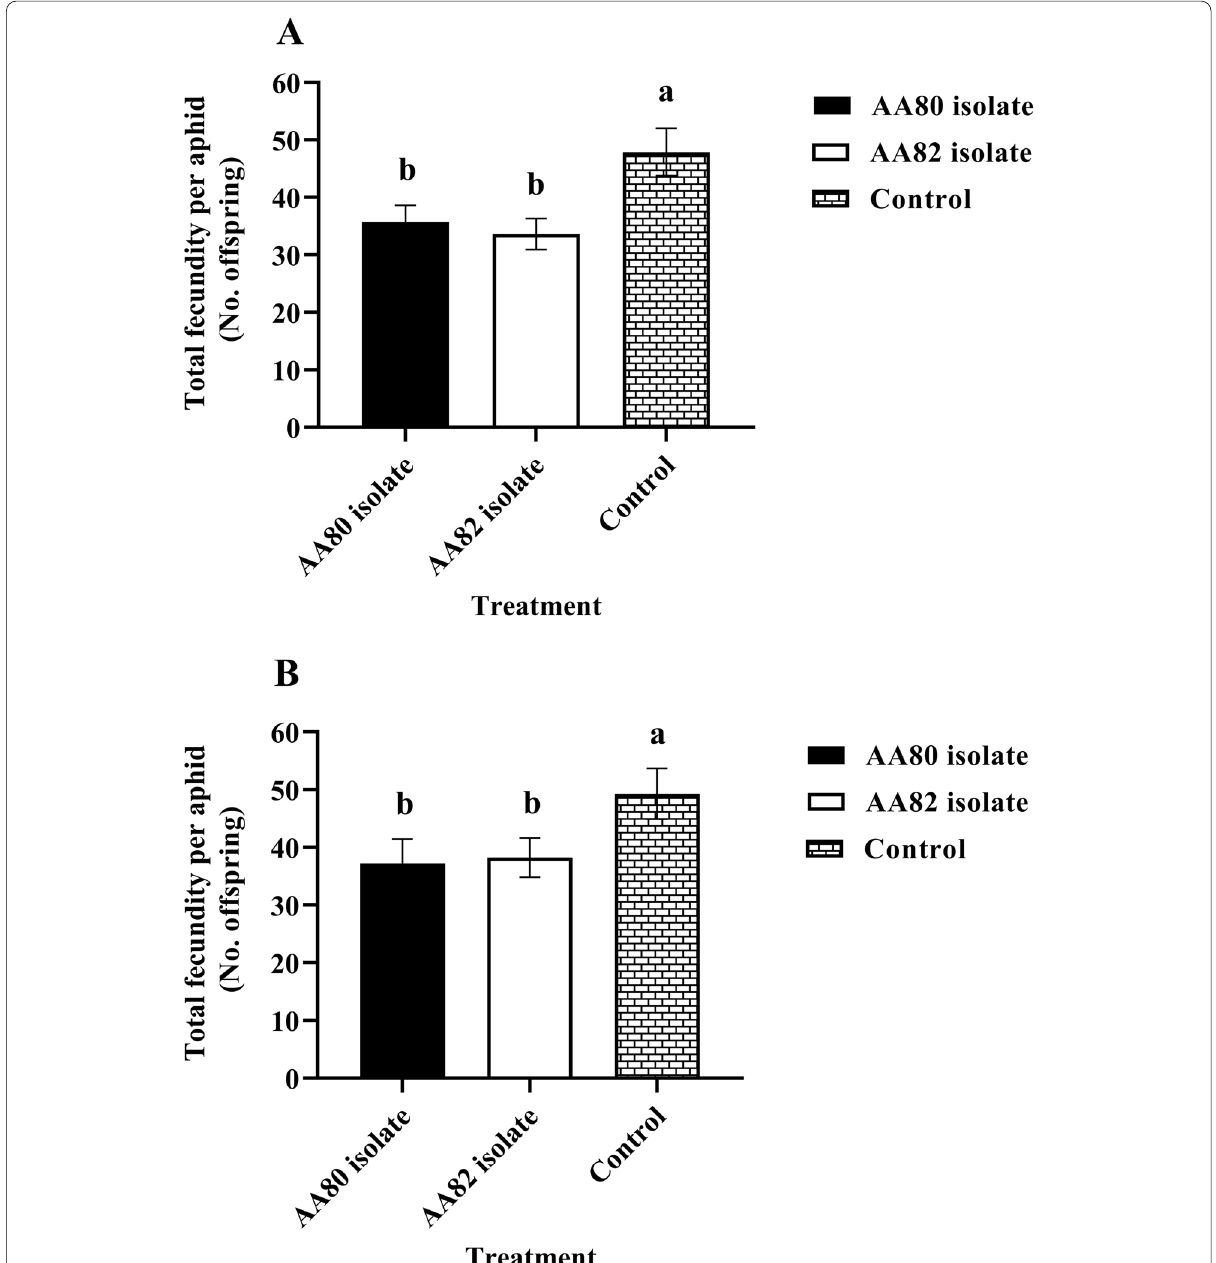
Fig. 3 Mean fecundity of M . persicae ( A ) and A . fabae ( B ) after treatment with 0.01% v/v Tween 80 solution (control) and two isolates of C . rosea . Bars topped with different letters are significantly different according to Turkey’s test at